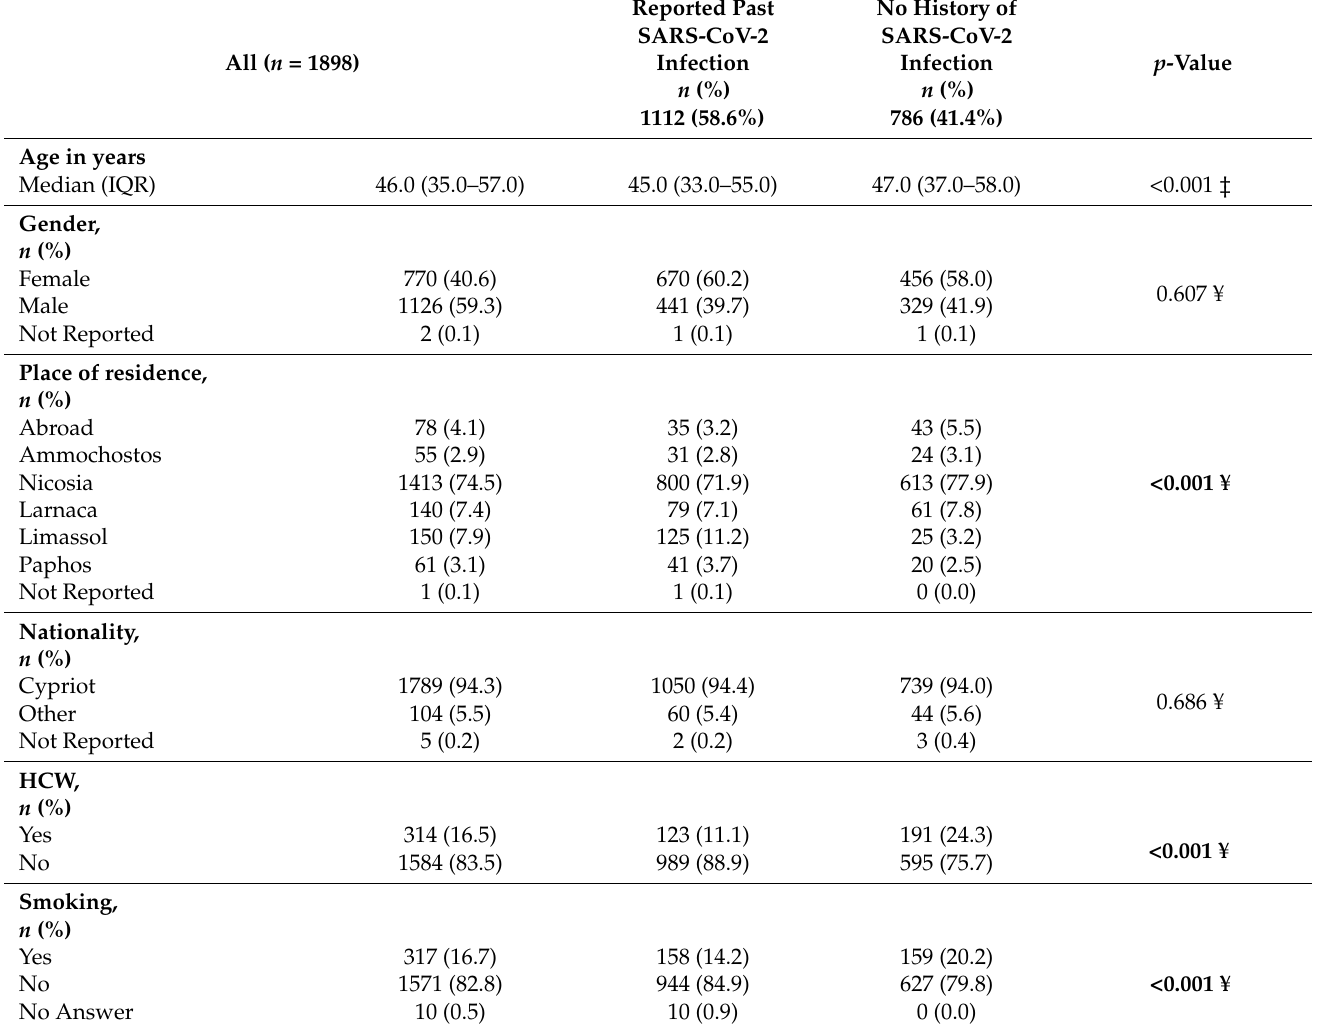
Table 1. Characteristics of participants tested for immunoglobulin class G (IgG) antibodies against